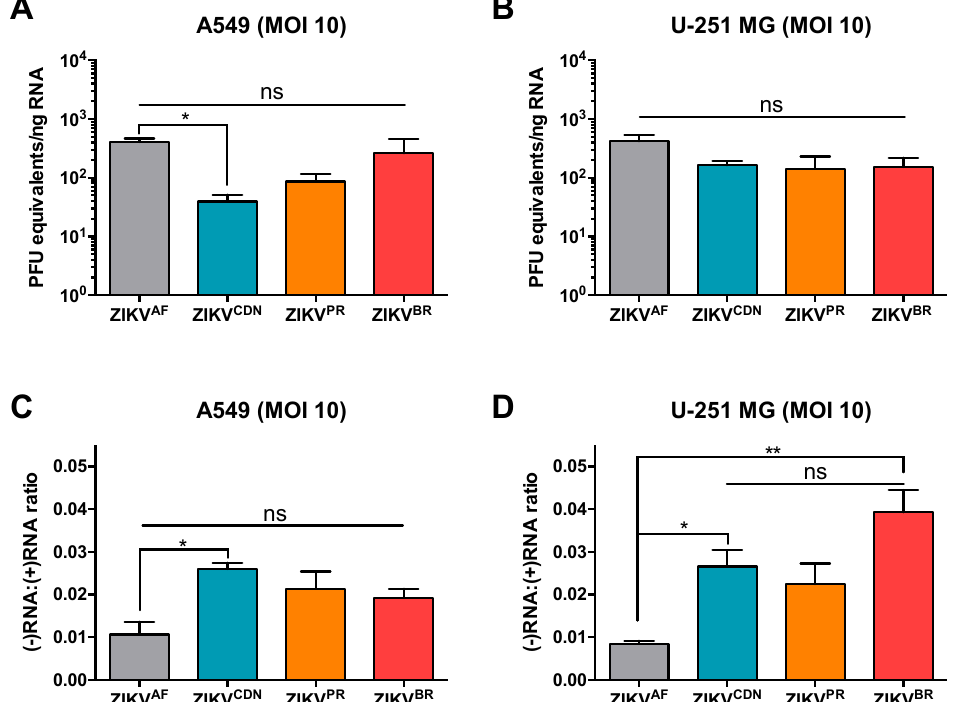
Figure 5. Asian lineage ZIKV isolates induce a higher ratio of negative:positive strand RNA. ( A ) A549 and ( B ) U-251 MG cells were infected with ZIKV at MOI = 10 and 24 h post-infection intracellular positive strand viral RNA was quantified by qRT-PCR. Data are normalized to GAPDH and expressed relative to a standard curve of PFU equivalents per ng input RNA. ( C ) A549 cells and ( D ) U-251 MG cells were infected with ZIKV at MOI = 10 and 24 h post-infection the relative amounts of positive and negative strand ZIKV genomes was quantified by qRT-PCR. Data are expressed as a ratio of negative:positive strand RNA. Values represent mean ± SEM of two or three independent experiments. Asterisks indicate significant differences: * p < 0.05, ** p < 0.01.